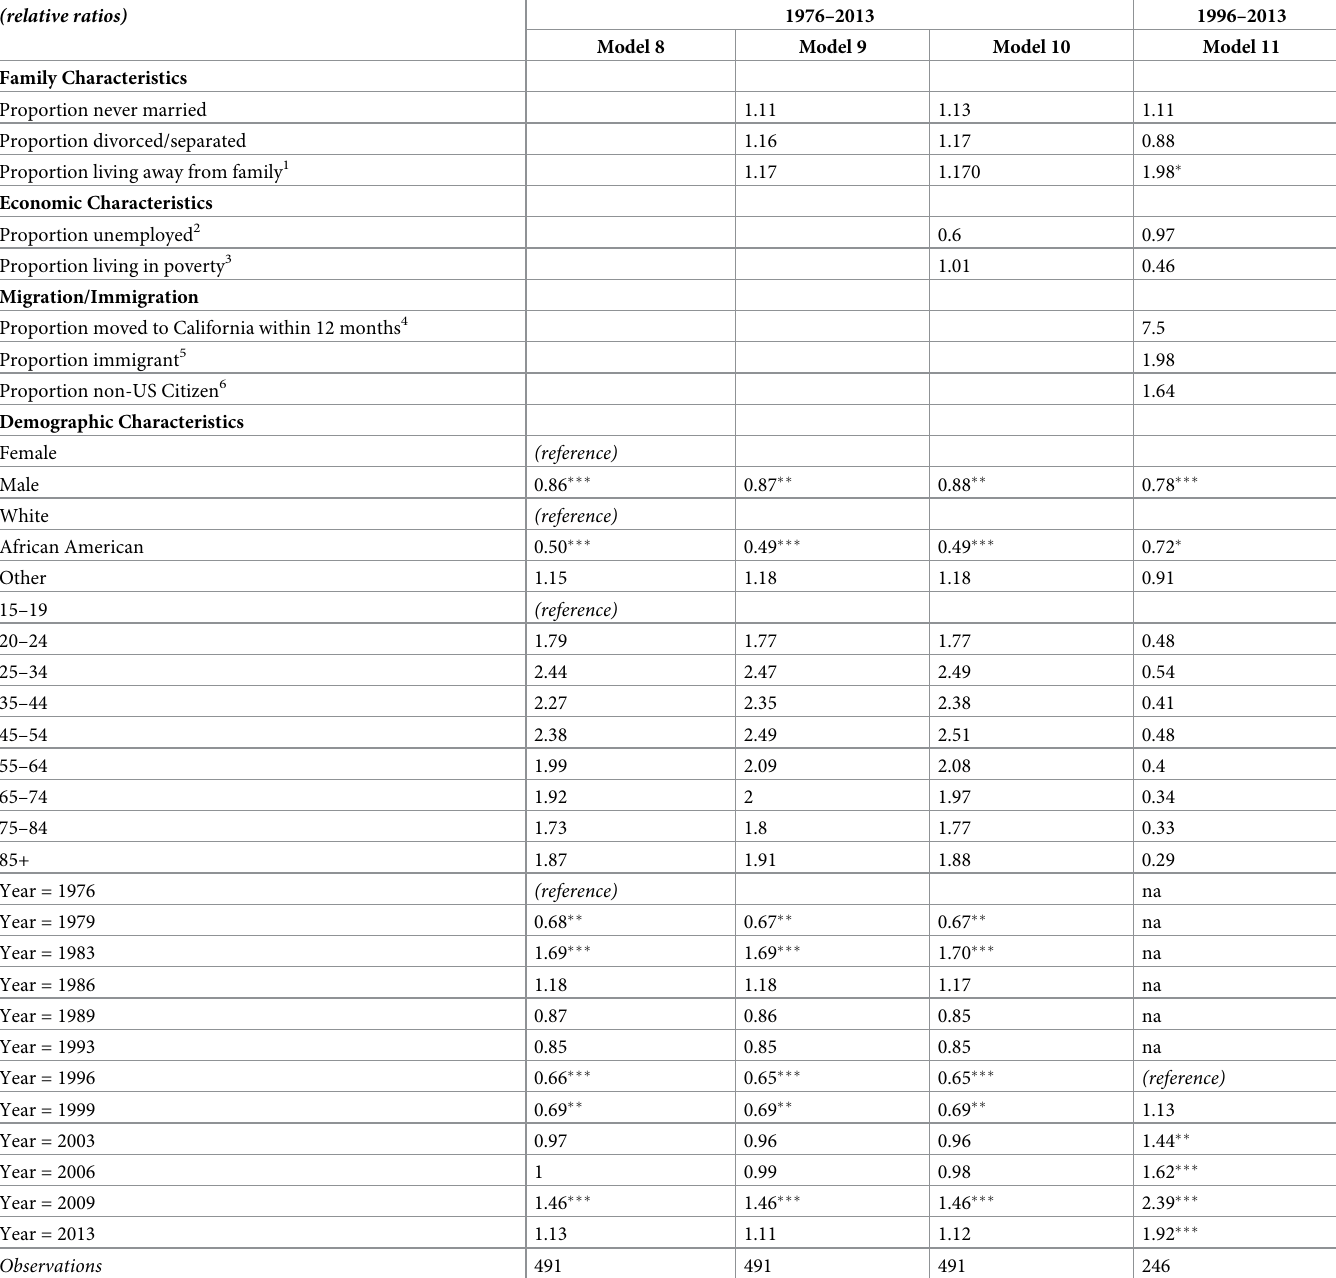
Table 5. Poisson estimation of relative rates of being reclaimed by socioeconomic